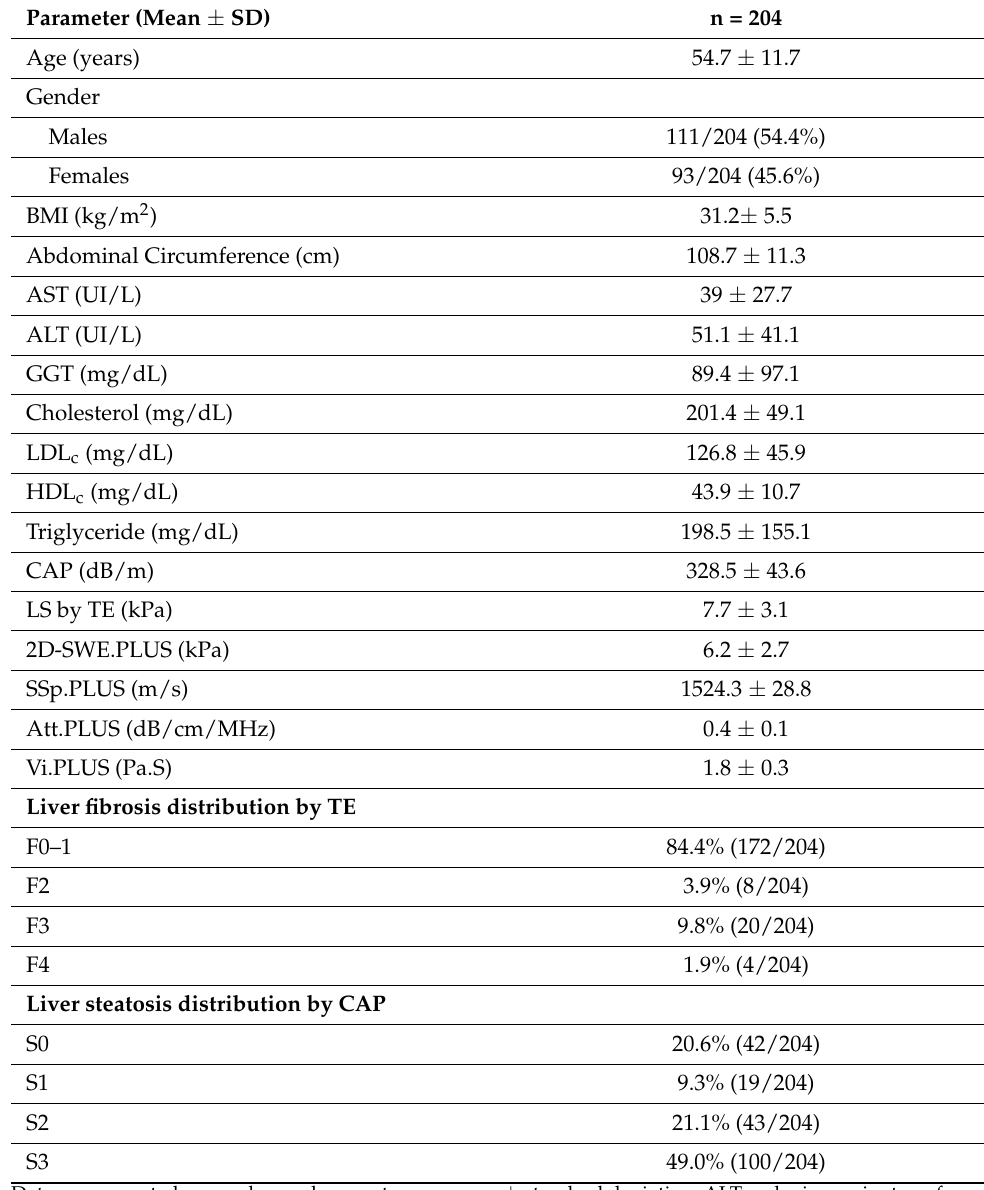
Table 1. Characteristics of subjects with reliable LSMs by both